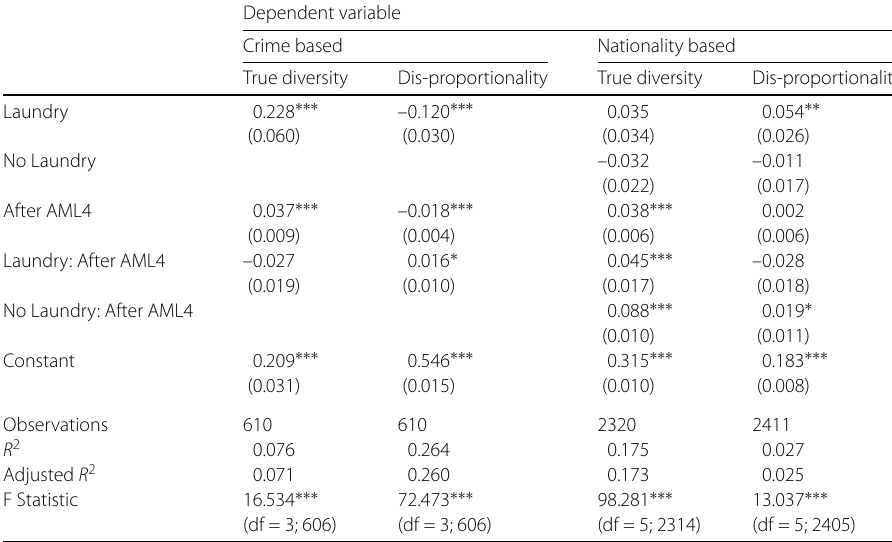
Table 5 Results of random effects regressions on cluster representation Dependent variable Crime